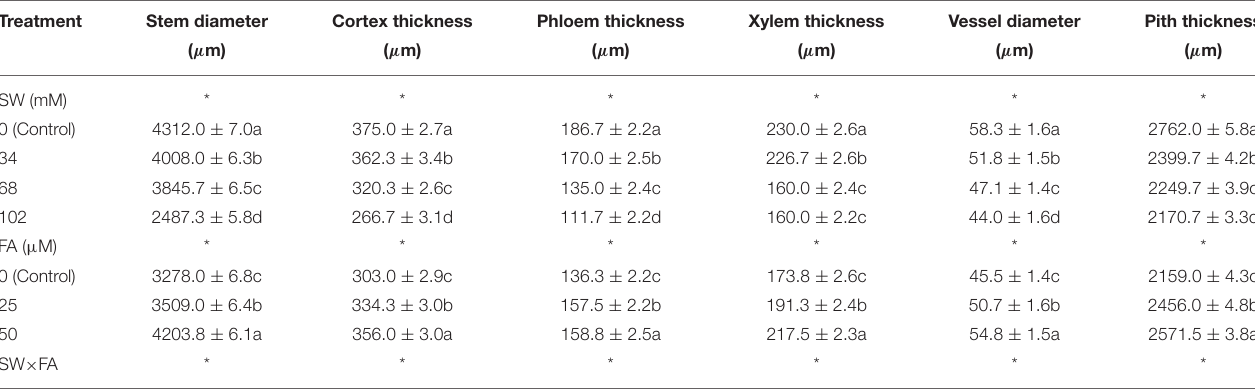
TABLE 6 | The effect of SW irrigation and FA spraying on the anatomical stem structures of Plectranthus amboinicus plants grown under greenhouse conditions. Treatment Stem